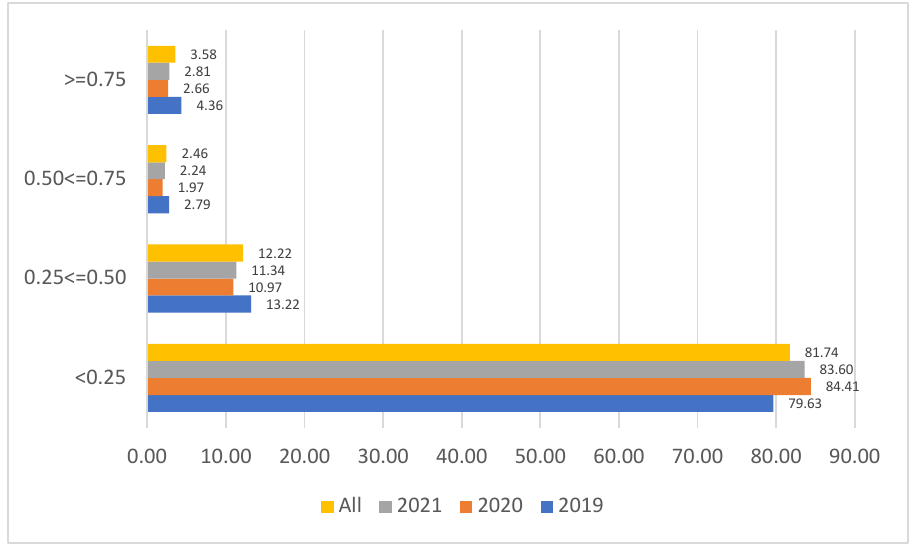
Figure 2. Distribution of fuzzy MEPI in 2019, 2020, and 2021. Source: GHS datasets (2019–2021). Table 2. Distribution of MEPI across the selected demographic variables in